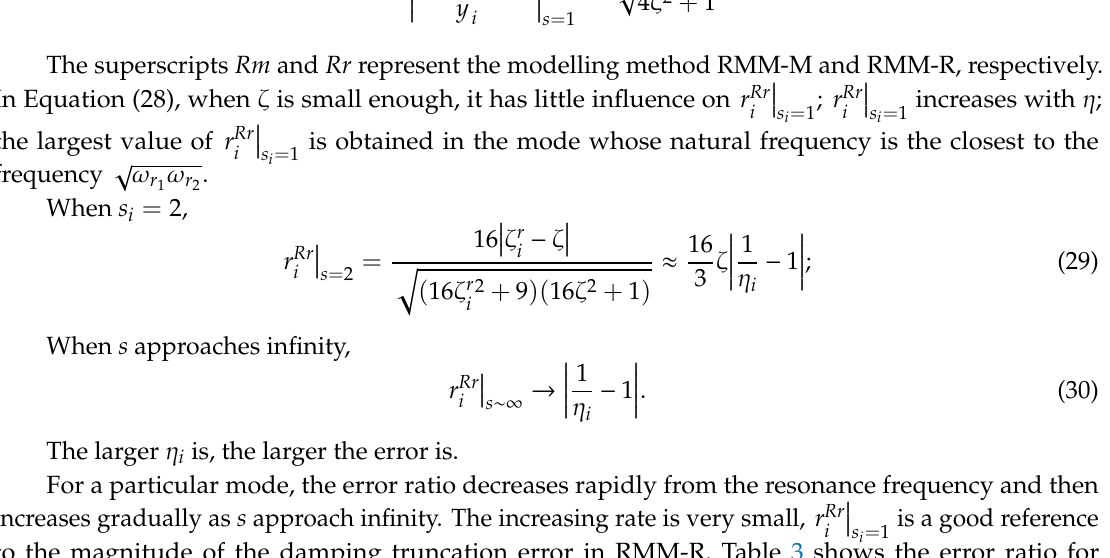
Table 3. Error ratio r Rr